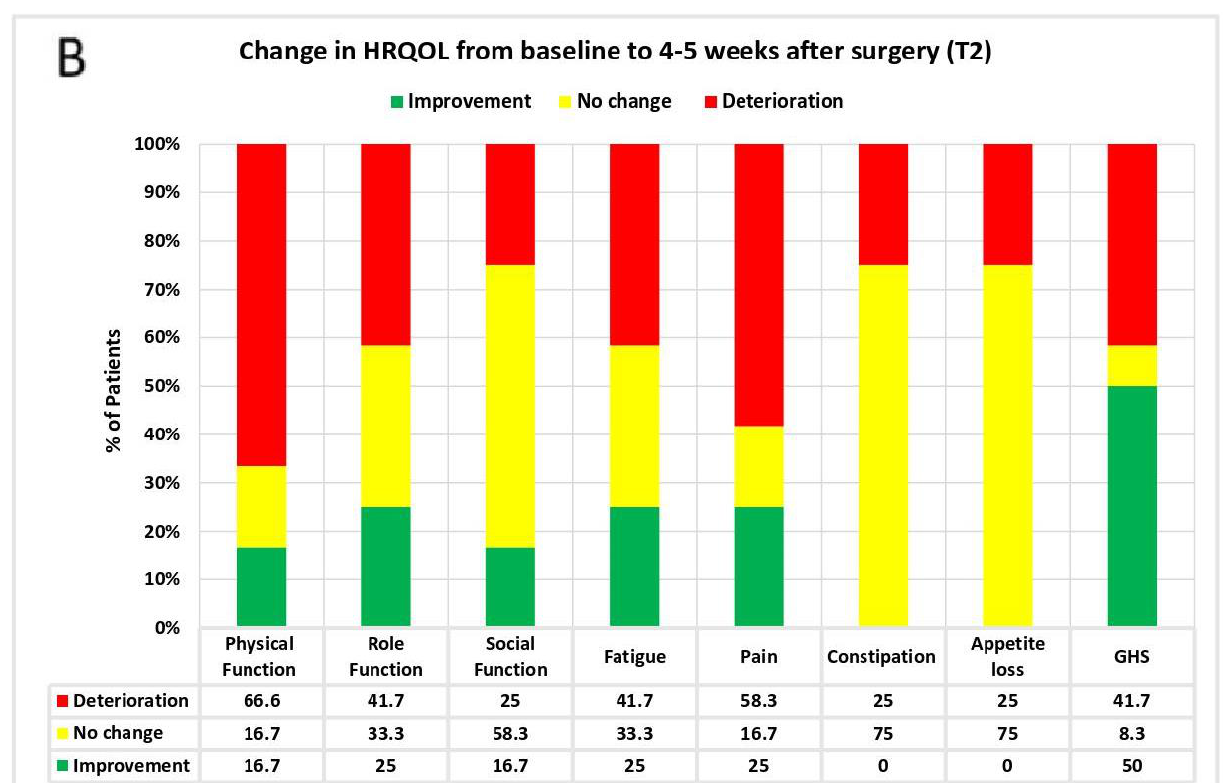
Figure 3. Changes in health-related quality of life based on minimal important difference. Legend: HRQOL (health-related quality of life); GHS (global health status). ( A , B ): Minimal important difference for improvement: global health status = 5 points; physical function = 6 points; social function = 6 points; role function = 9 points; fatigue = 6 points; pain = 9 points; appetite loss = 8 points; constipation = 13 points/Minimal important difference for deterioration: global health status = − 5 points; physical function = − 7 points; social function = − 5 points; role func- tion = − 9 points; fatigue = − 9 points; pain = − 12 points; appetite loss = 8 points; constipa- tion = − 10 points